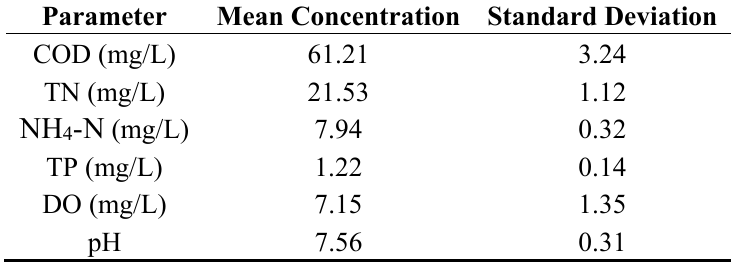
Table 1. Characteristics of influents from the wetland microcosm units ( n = 30).